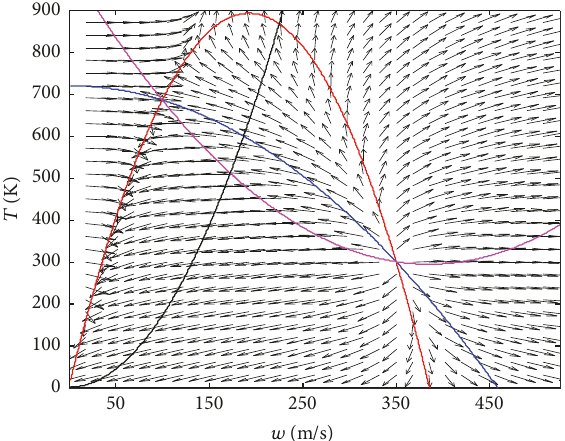
Figure 6: Direction field in the phase diagram for Pr =